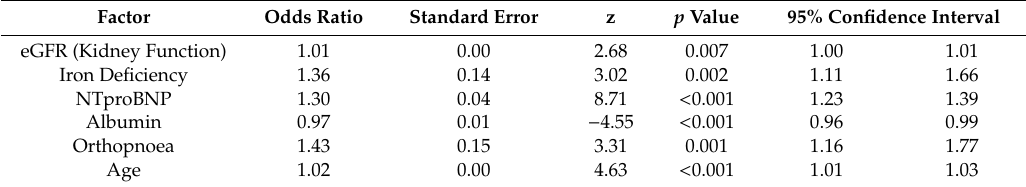
Table 1. Independent determinants of low selenium